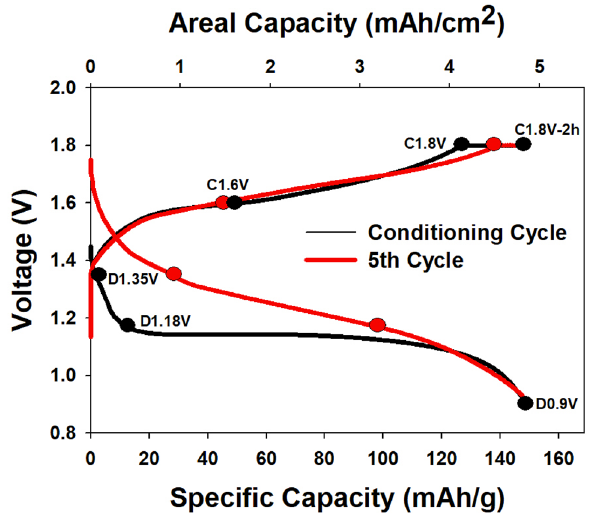
Figure 2. Discharge/charge voltage profiles for the first and fifth cycles of a Zn||EMD cell showing where electrodes were extracted for